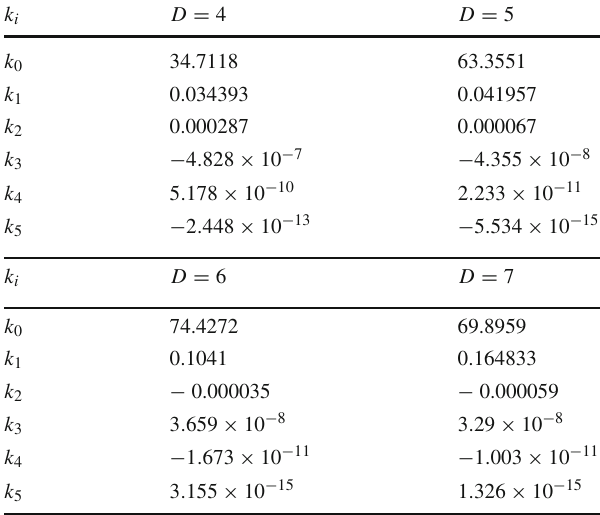
Table4 Valuesofcoefficients k i indifferentdimensionsforEXO1745- 248 taking α = 0 . 1 and γ = 0 .